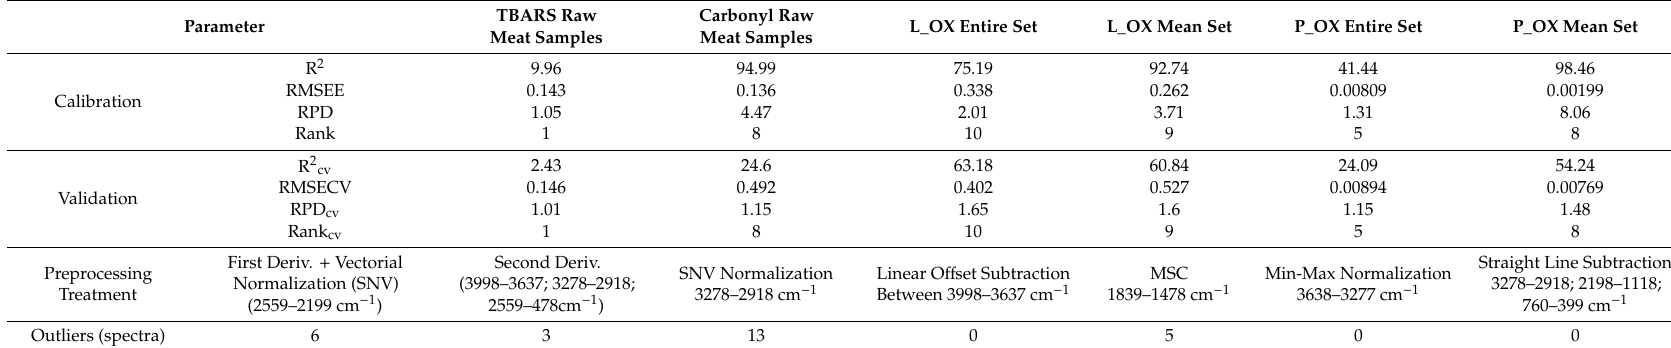
Table 3. Results of the predictive models (calibration and validation), of the TBARS, carbonyls studied in raw meat and L_OX (lipid oxidation) and P_OX (protein oxidation) marker